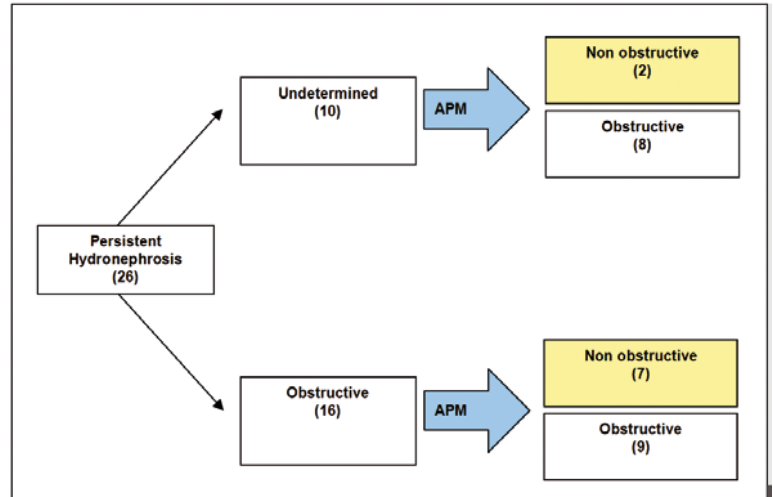
figure 2 - flowchart of cases and test